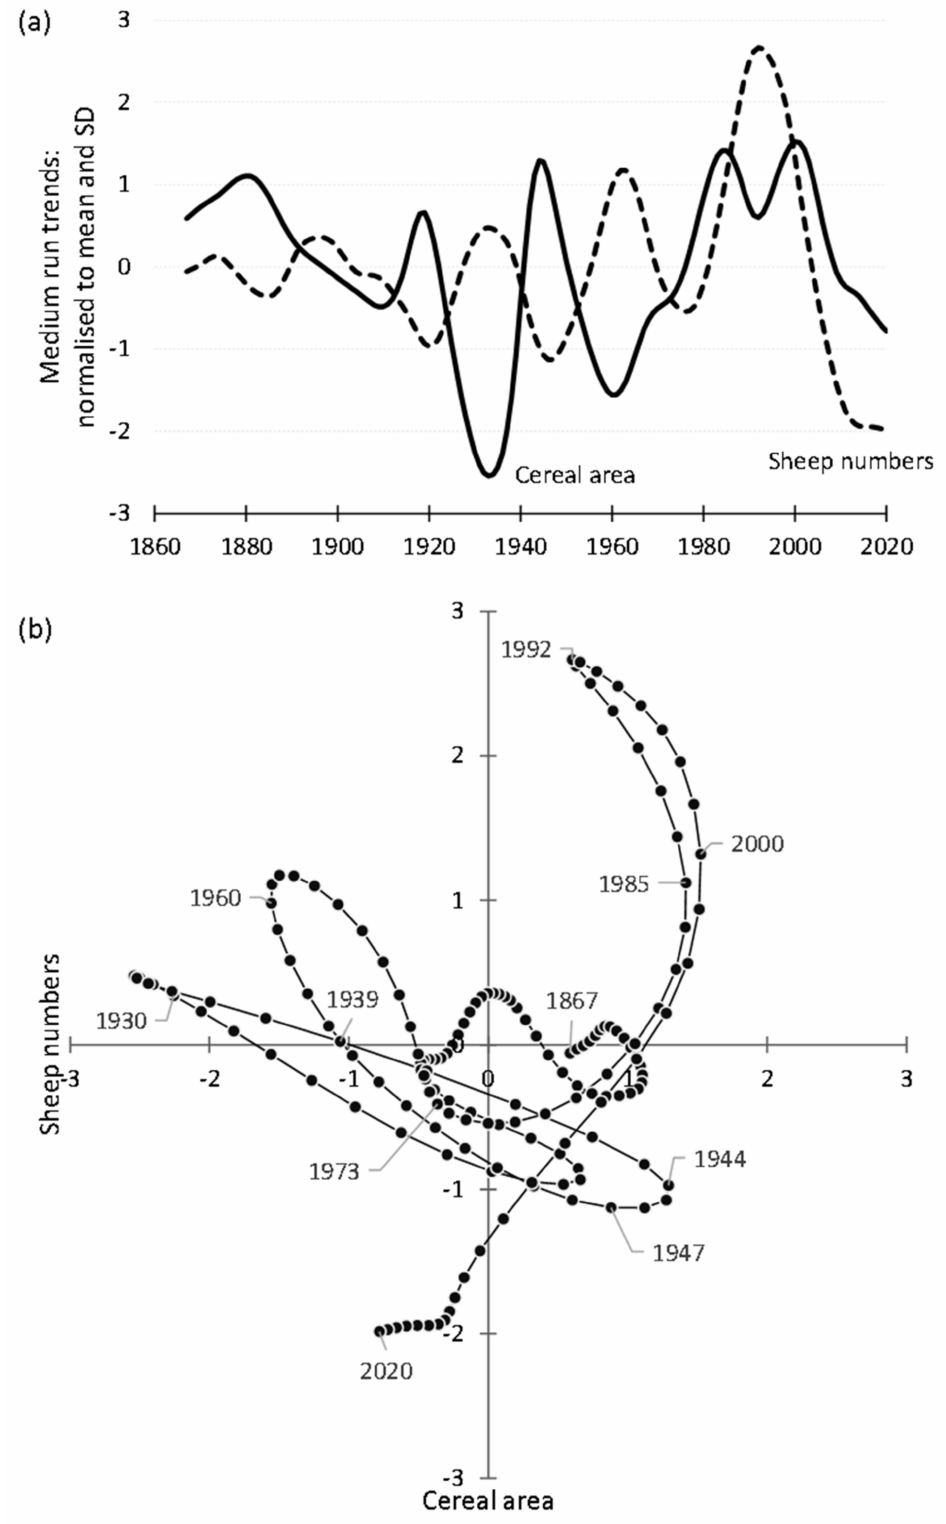
Figure 8. Medium-term patterns of variation for cereal area and sheep numbers in Scotland (1867–2020) as ( a ) time series and ( b ) phase plots. Note: the variables are normalized to account for differences in